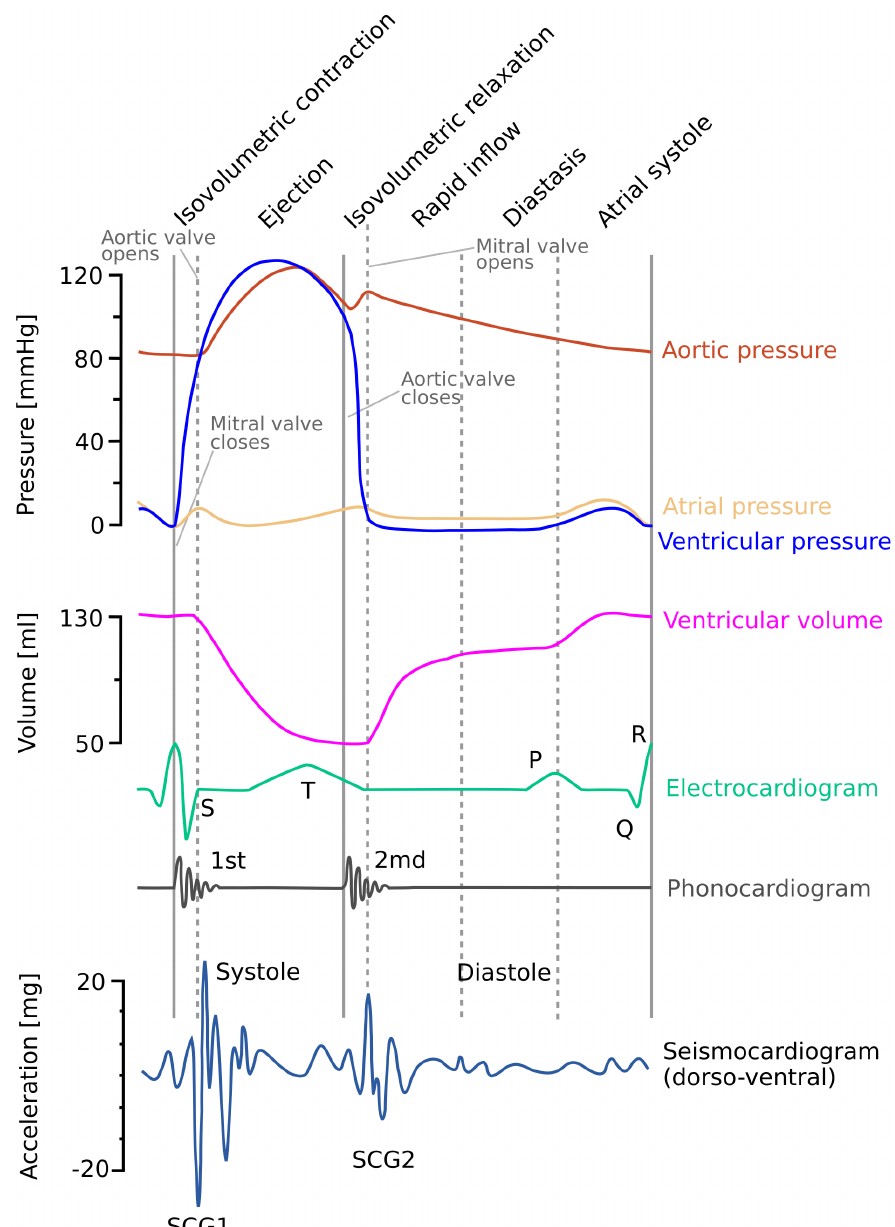
Figure 8. Modified Wiggers diagram. A sample of the SCG signal in the dorso-ventral (z) axis is shown alongside other cardiovascular signals: the aortic pressure, atrial pressure, ventricular volume, electrocardiogram, and phonocardiogram. The mitral valve closure (MC) and opening (MO), and aortic valve closure (AC) and opening (AO) are labeled based on the pressure signals. Modified version